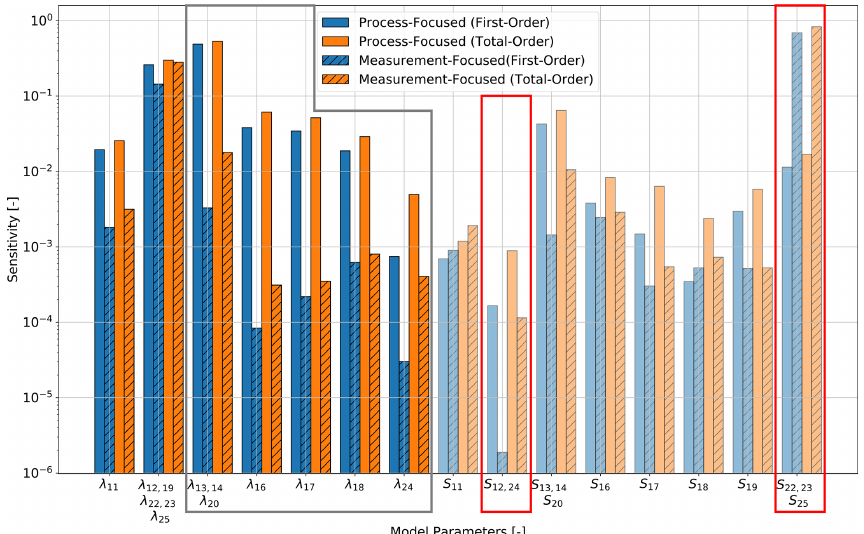
Figure 9. Sensitivity analysis of the upper crust with different quantities of interest of the hierarchical global sensitivity analysis for the General-Focus Alps model. For the layer IDs and symbols, please refer to Table